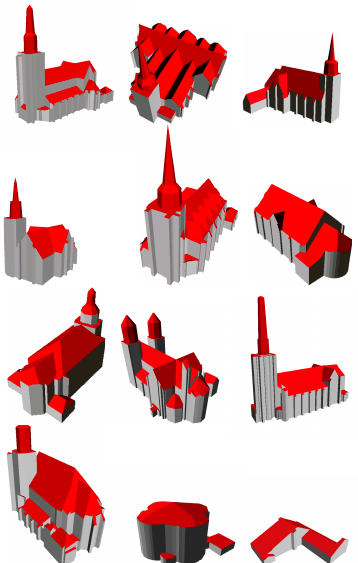
Figure 21: A collection of data-driven church